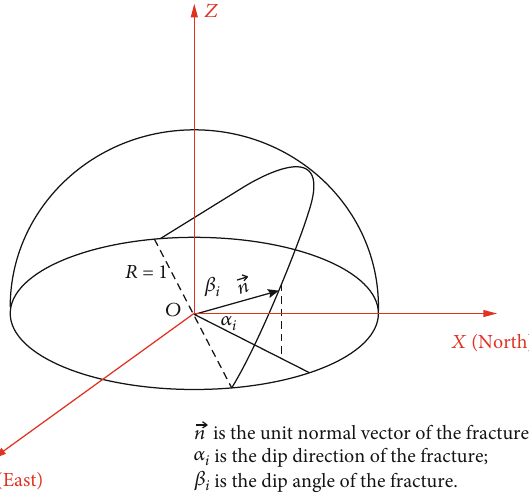
Figure 8: Schematic diagram of unit normal vector of fracture orientation in geographic coordinate